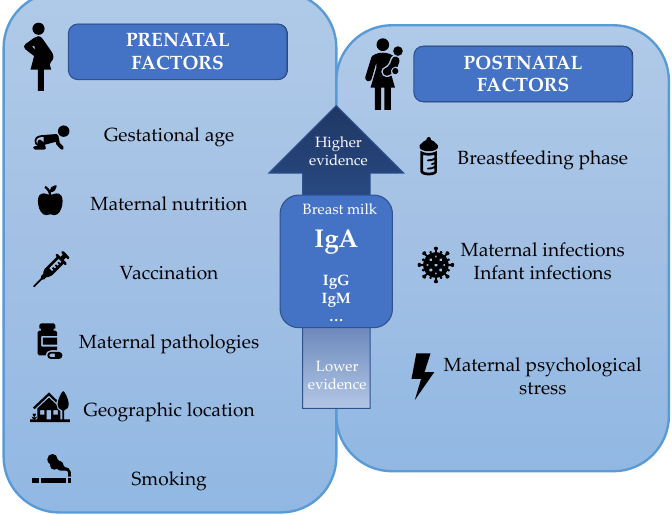
Figure 7. Prenatal and postnatal factors influencing breast milk immunoglobulinome. The factors are displayed from the highest to lowest level of evidence.